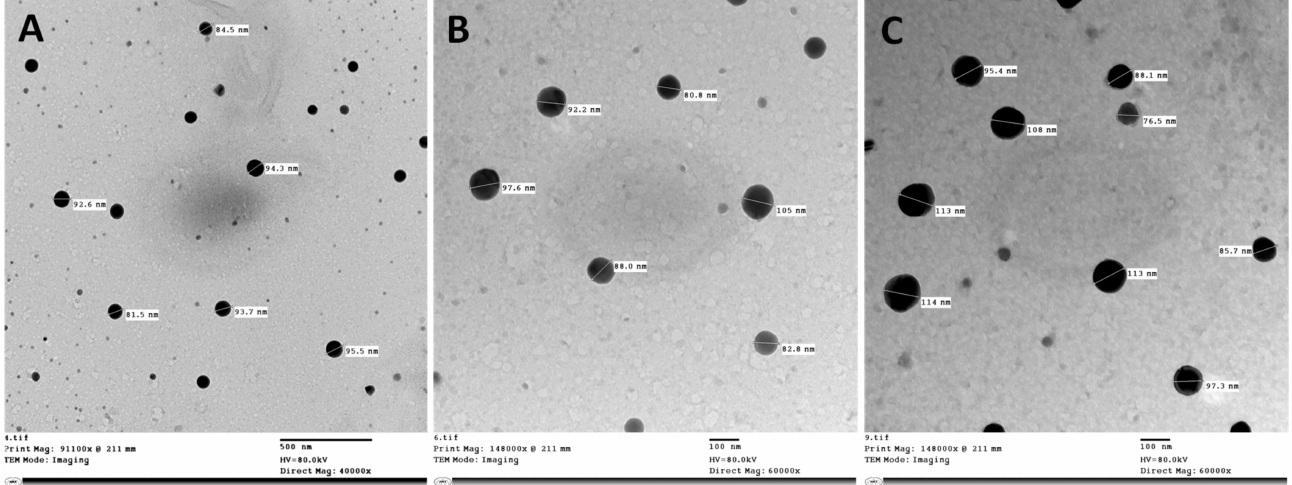
Figure 1. TEM images of rhamnolipid nano-micelles prepared at rhamnolipids concentration ( A ) 20, ( B ) 78, and ( C ) 312 µ g/mL,